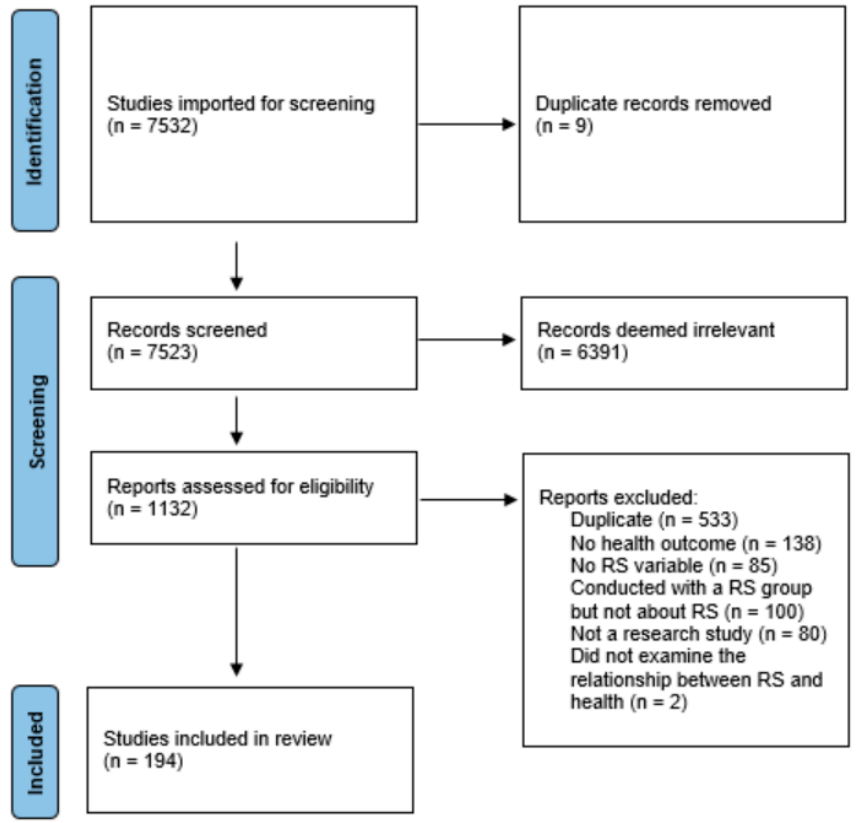
Figure 1. PRISMA flow diagram. Table 1. Proposed study demographics and R/S characteristics (k =